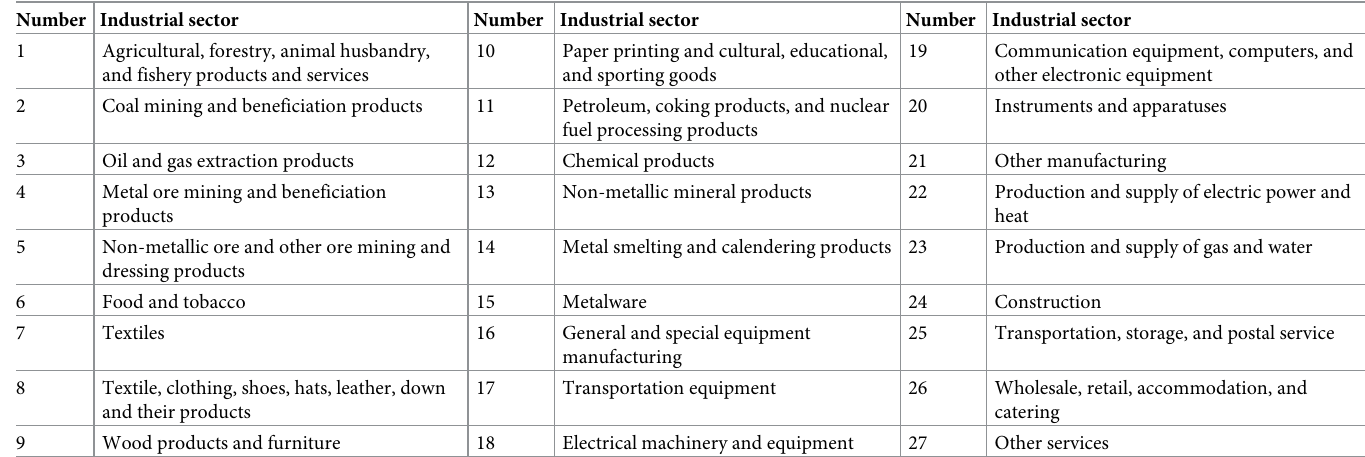
Table 1. Numbers and description of Chinese industrial